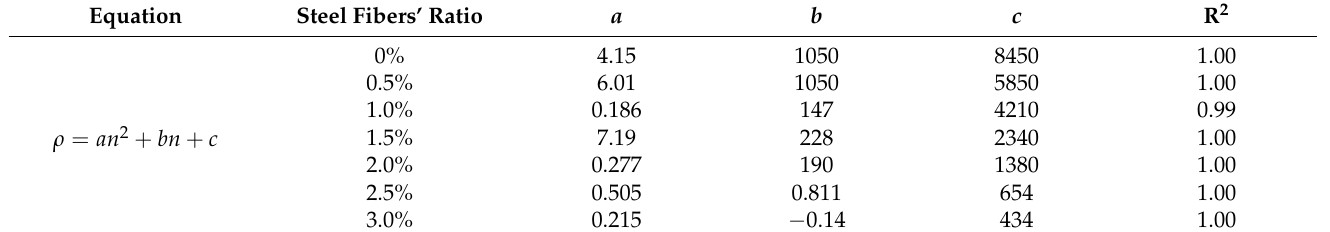
Table 8. The fitting results of the relationship between ρ and the n .